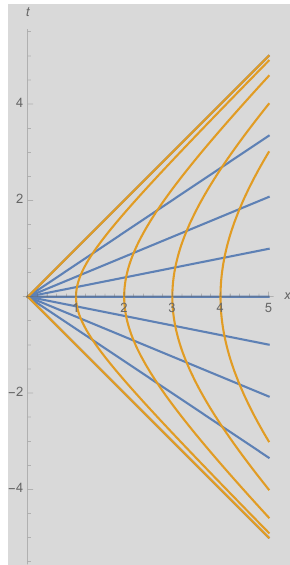
Figure 1 . Trajectories of constant Rindler timeslice ξ 0 = 1 spaceslice ξ 1 = x 2 − t 2 = const., along with the past and future Rindler horizons at t = − x and t = x . Rindler coordinates only cover one-quarter of the Minkowski